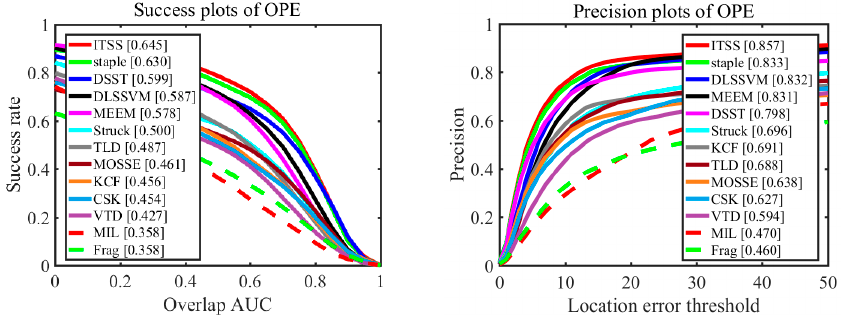
Figure 5. Distance precision and overlap success plots on entire OTB-2013 dataset using OPE.